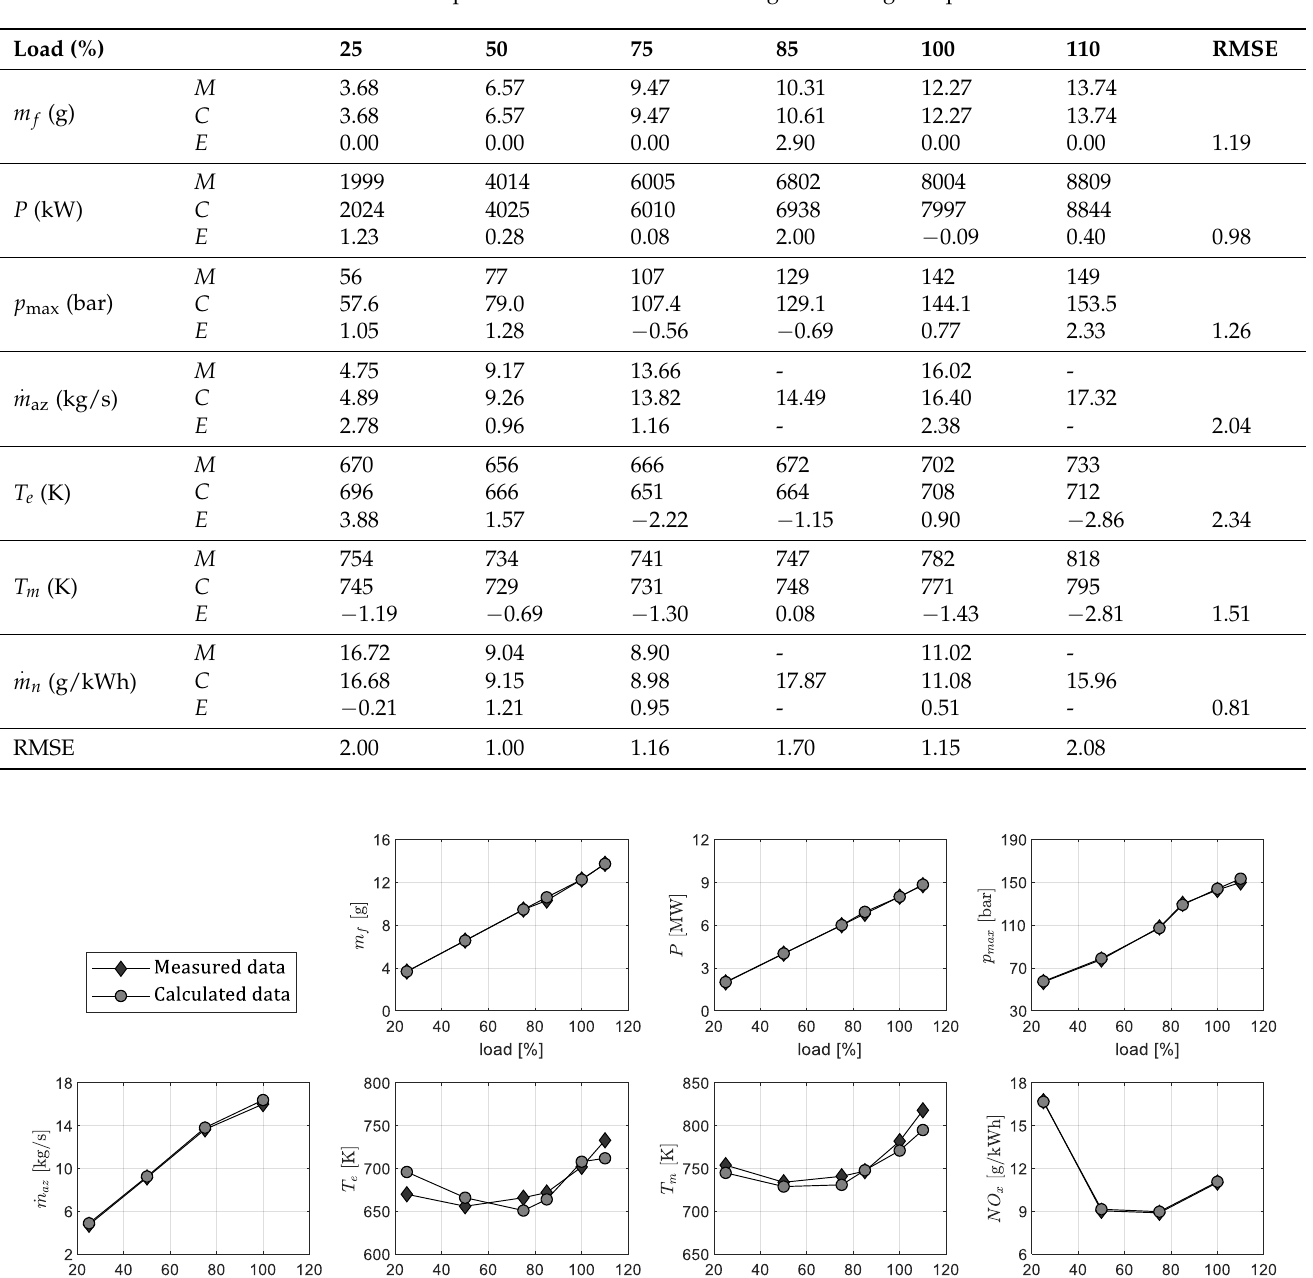
Table 3. The performance of the dual-fuel engine running in liquid fuel mode with the SL model.